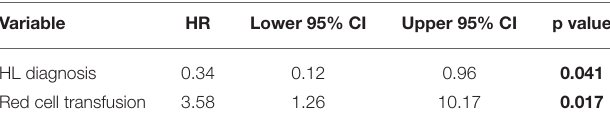
Table 5C | OS multivariate analysis.